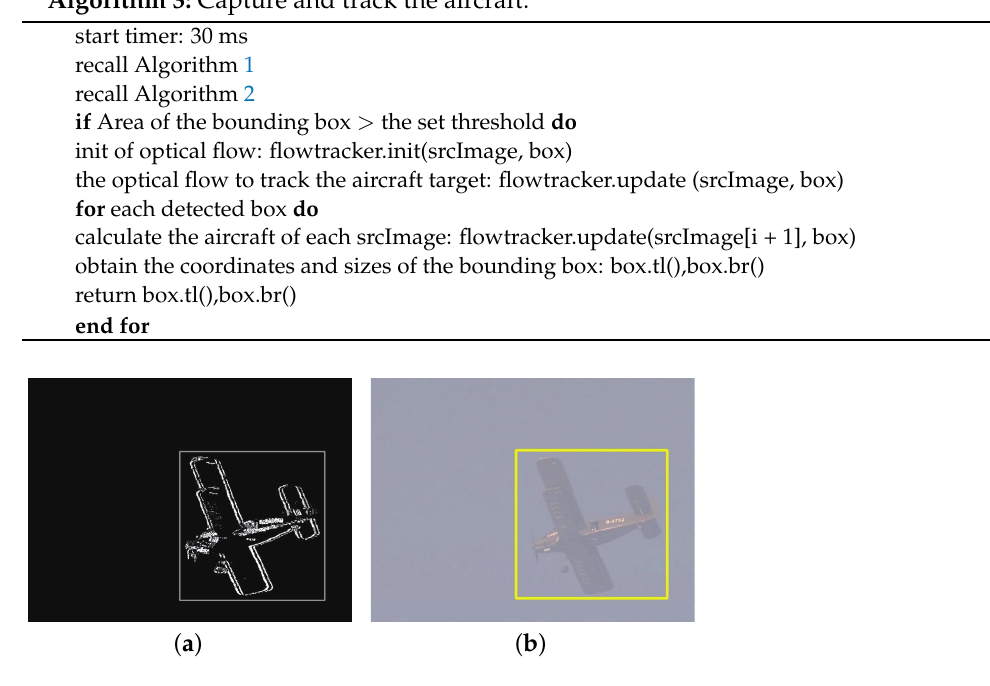
Figure 10. Capture and track the aircraft targets. ( a ) The aircraft target capture; ( b ) transfer the coordinates and size of the box to the corresponding original image.